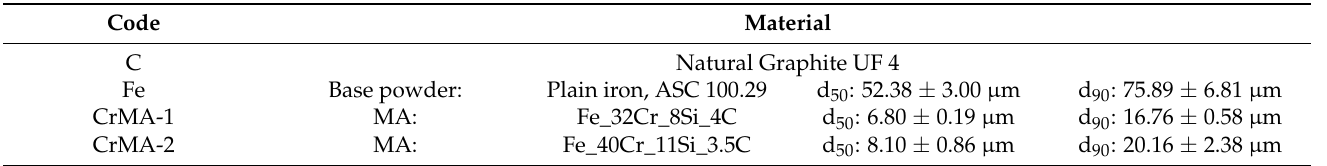
Table 1. List of materials used in the present study. Natural graphite UF 4, (Kropfmühl), Fe base powder ASC 100.29 (Höganäs AB, Sweden), MA (Ultra High Pressure Water Atomized master alloys produced by Atomizing Systems Ltd., UK). Code Material C Natural Graphite UF 4 Fe Base powder: Plain iron, ASC